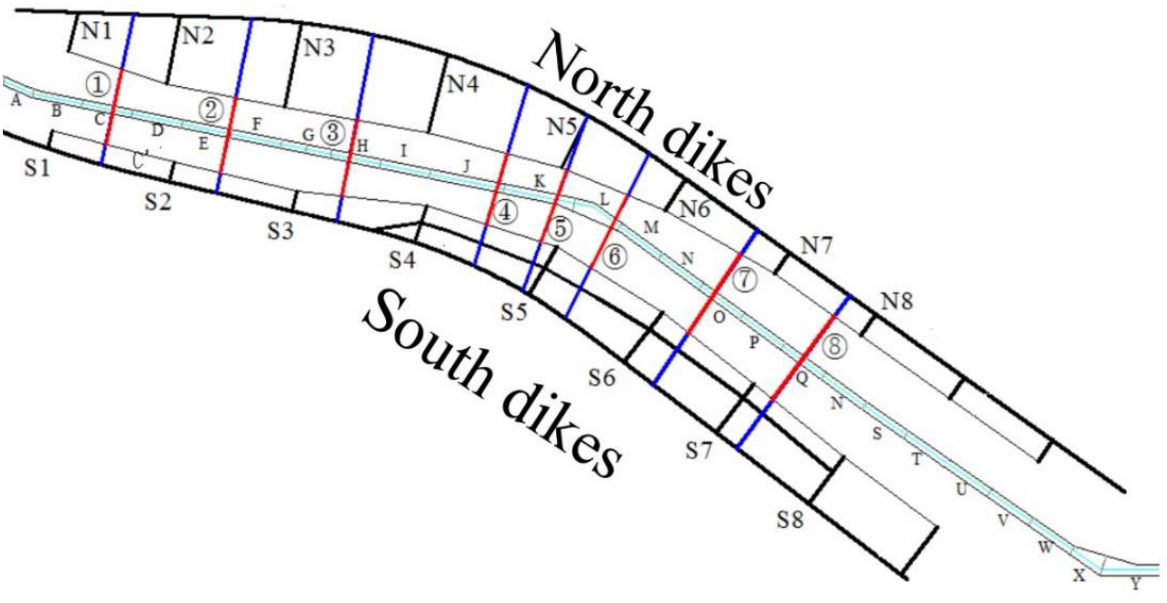
Figure 7. Positions of the sections in North Passage after the project.